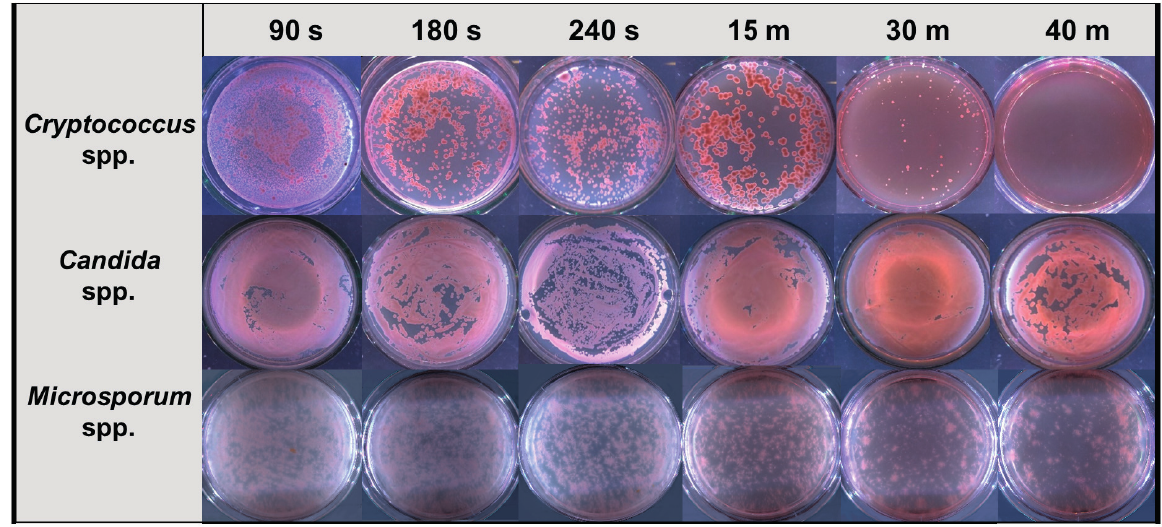
Figure 2. Fungal growth performance in different agars made by microwave oven (90, 180, and 240 seconds) and autoclave (15, 30, and 40